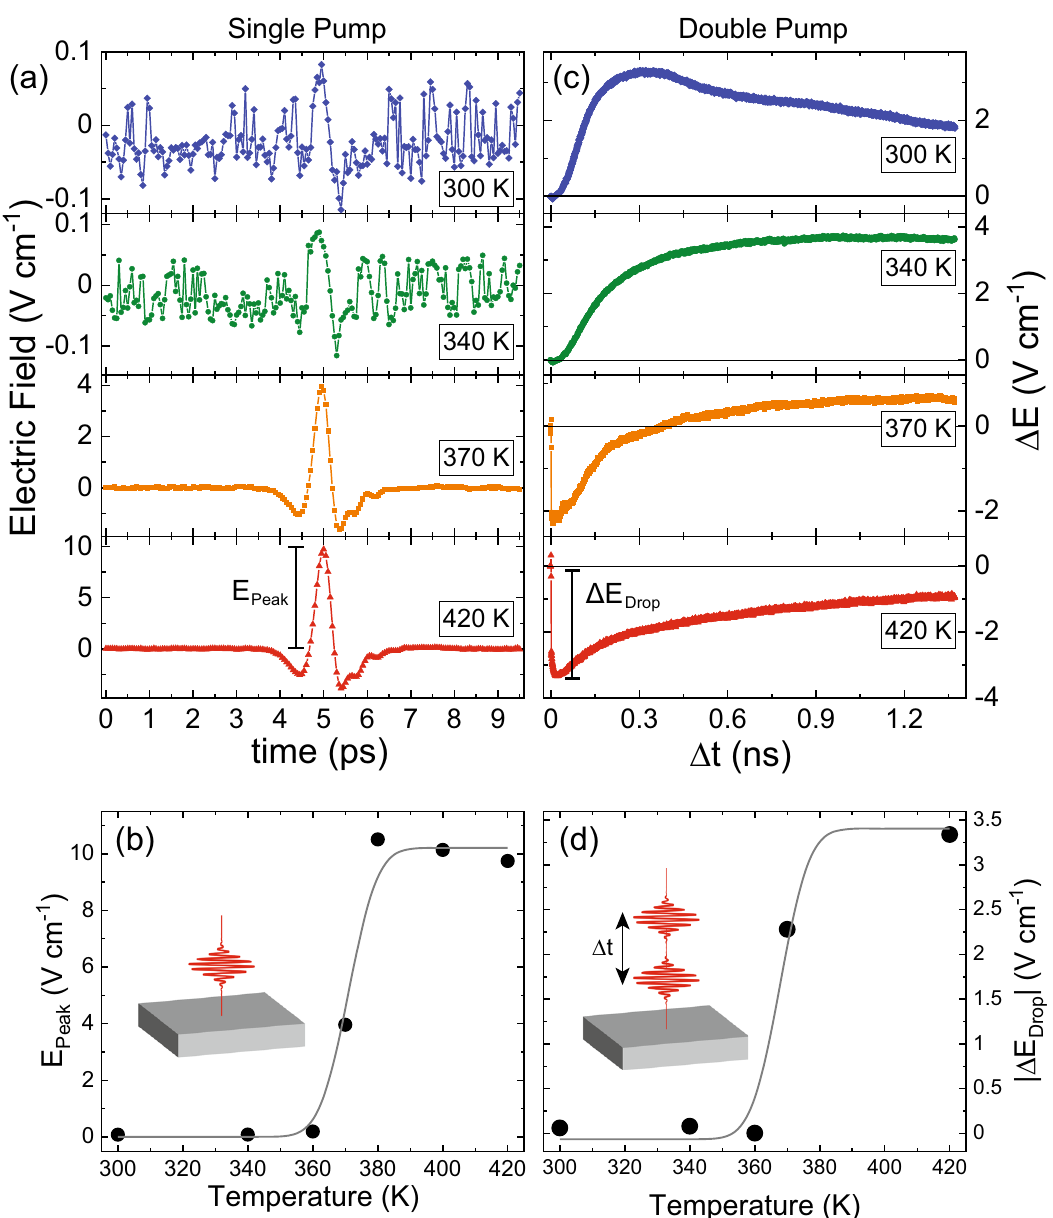
Fig. 2 Single-pump and double-pump THz emission below and above the temperature of the phase transition T PT . Left column: a The time-traces of the THz electric fi eld at several temperatures with μ H ¼ 120 mT. b The peak amplitude of the THz electric fi eld triggered by a single-pump as a function of 0 initial temperature of the sample. Right column: c The change in Δ E as a function of the delay time, Δ t, between pump 1 and pump 2 at several temperatures with μ H ¼ 120 mT. d The absolute value of the sub-picosecond drop of the double-pump THz emission, Δ E, as a function of temperature. 0 The solid lines in b and d serve as a guide to the